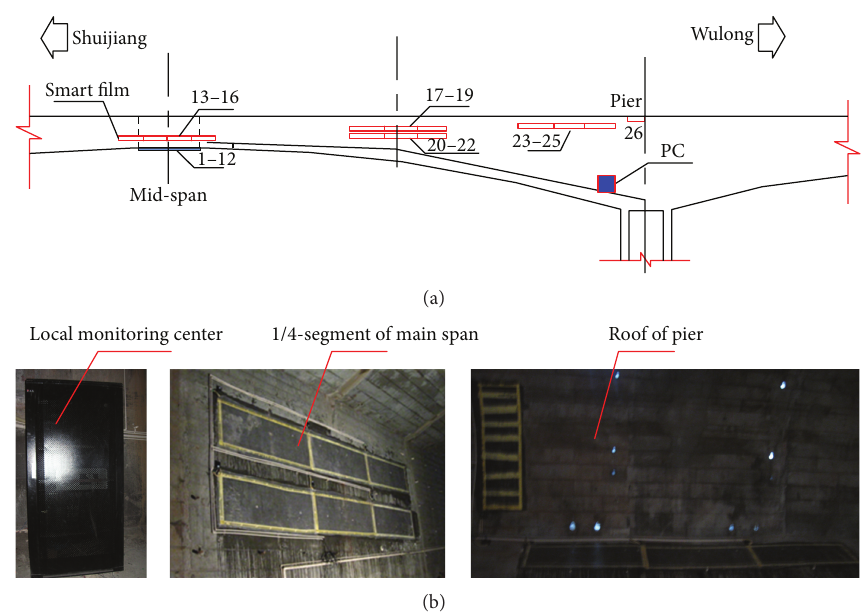
Figure 16: (a) Layout of smart film sensors and (b) the local monitoring center and smart film sensors.